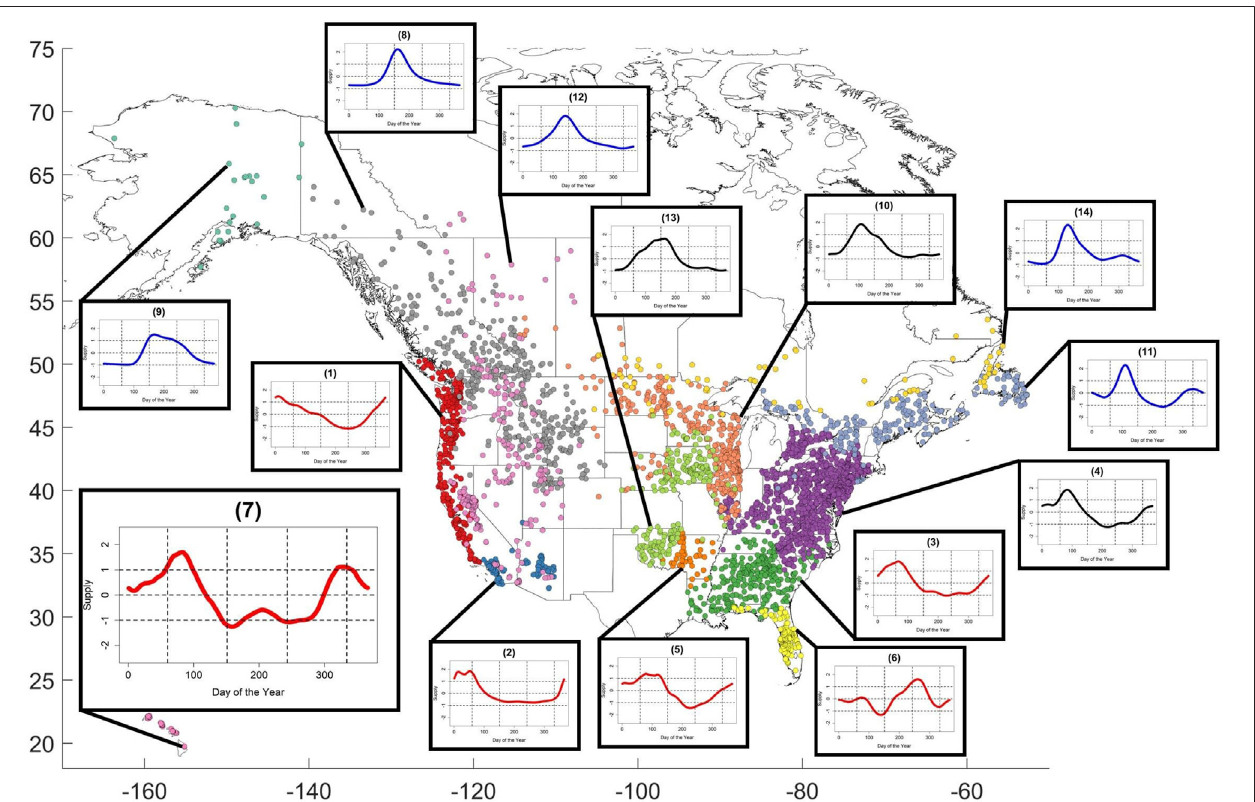
FIGURE 4 | Clusters with their average normalized stream fl ow regime curve. The clusters are: 1) West Coast, 2) Southwest, 3) Deep South, 4) Mid-Atlantic, 5) South-CentralUS, 6)Florida, 7) Hawaii,8) Rockies,9)Alaska,10)Midwest, 11)Northeast,12)West, 13)Central US, 14)EasternCanada.Thecolorsoftheregimecurve indicate the regime categories where red, black, and blue indicate rain dominated, rain-on-snow dominated, and snowmelt dominated regimes respectively. Vertical dashed curves in the graphs are placed at the transition of seasons (winter, spring, summer, fall).